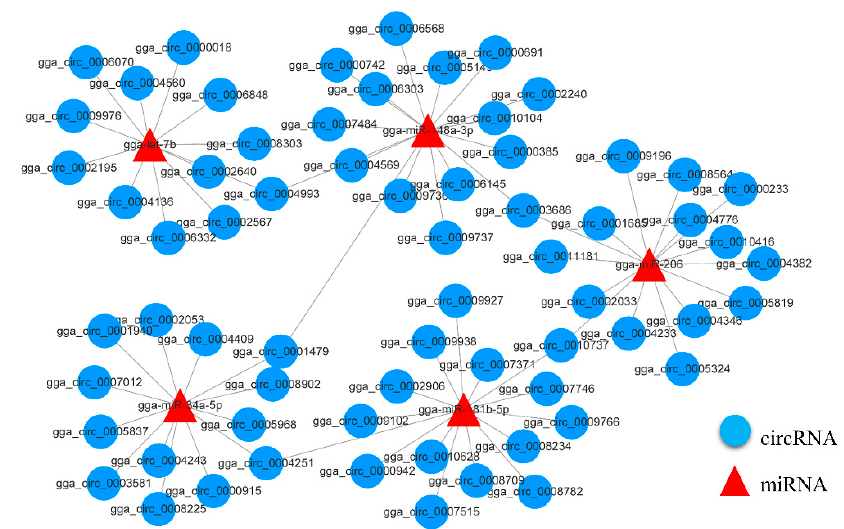
Figure 5. CircRNA-miRNA interaction network associated with skeletal muscle development. miRNAs and CircRNAs are expressed as triangles and circles, respectively. Figure 5. CircRNA ‐ miRNA interaction network associated with skeletal muscle development. miR ‐ NAs and CircRNAs are expressed as triangles and circles, respectively.